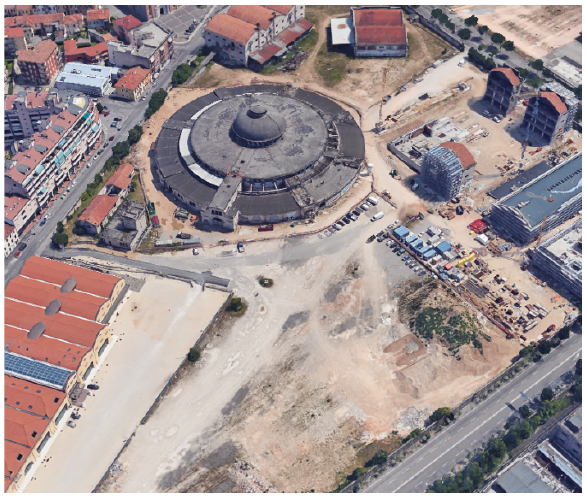
Figura 2. Aerial 3-D view of Stazione Frigorifera (circular building) and some other sectors of Magazzini Generali, during (source: Google